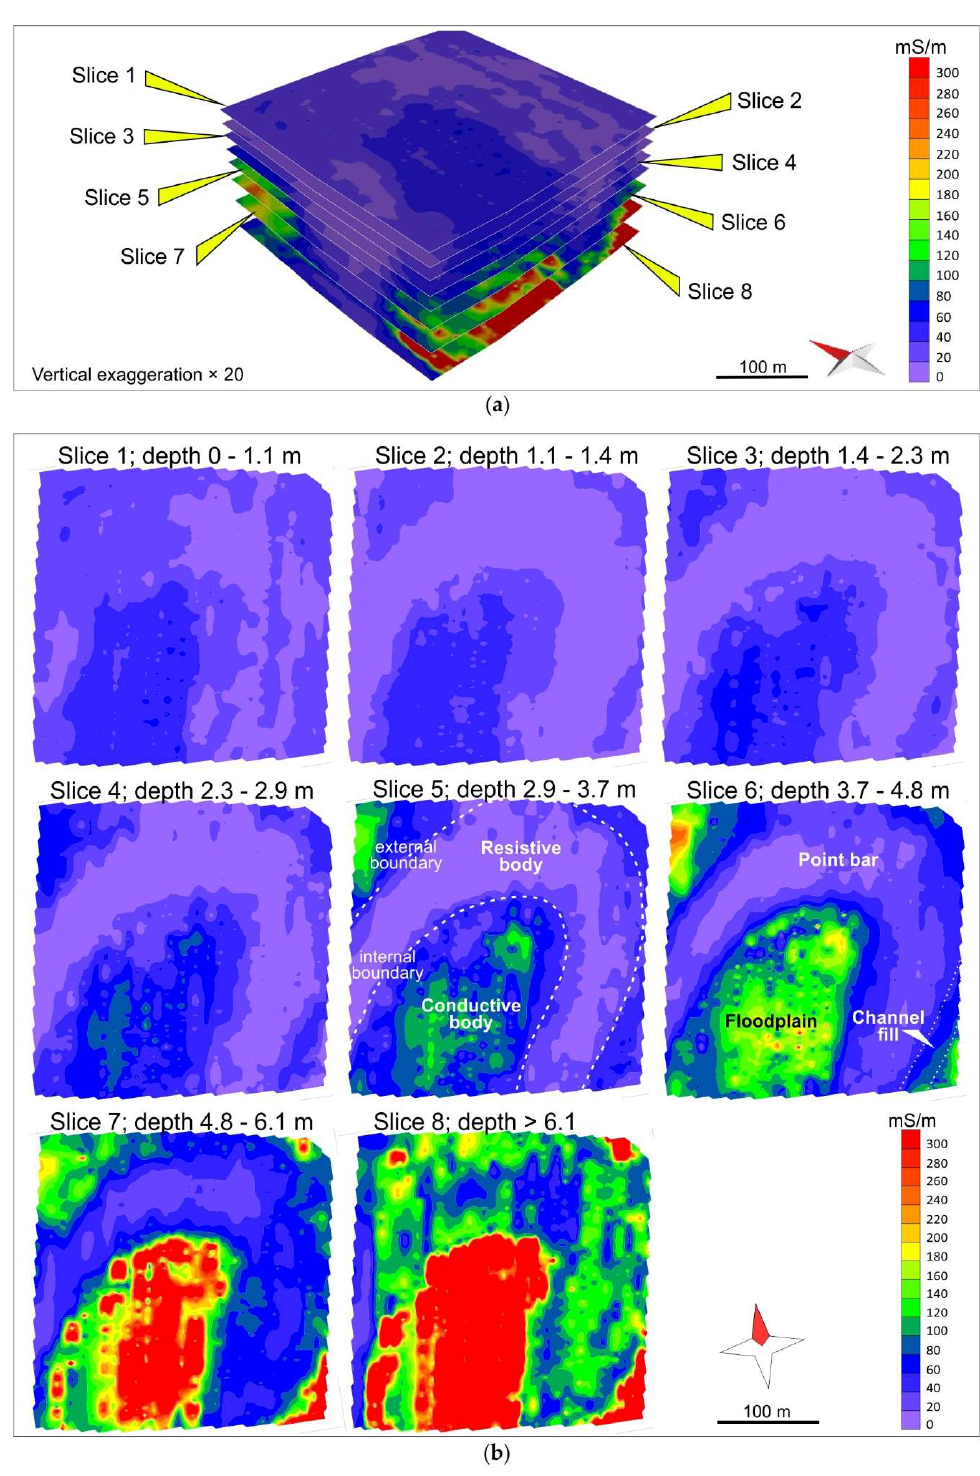
Figure 6. Geophysical results: ( a ) 3D view of the eight 2D conductivity maps; ( b ) the eight 2D maps showing difference in conductivity values and highlighting point-bar, channel-fill and floodplain morphologies.